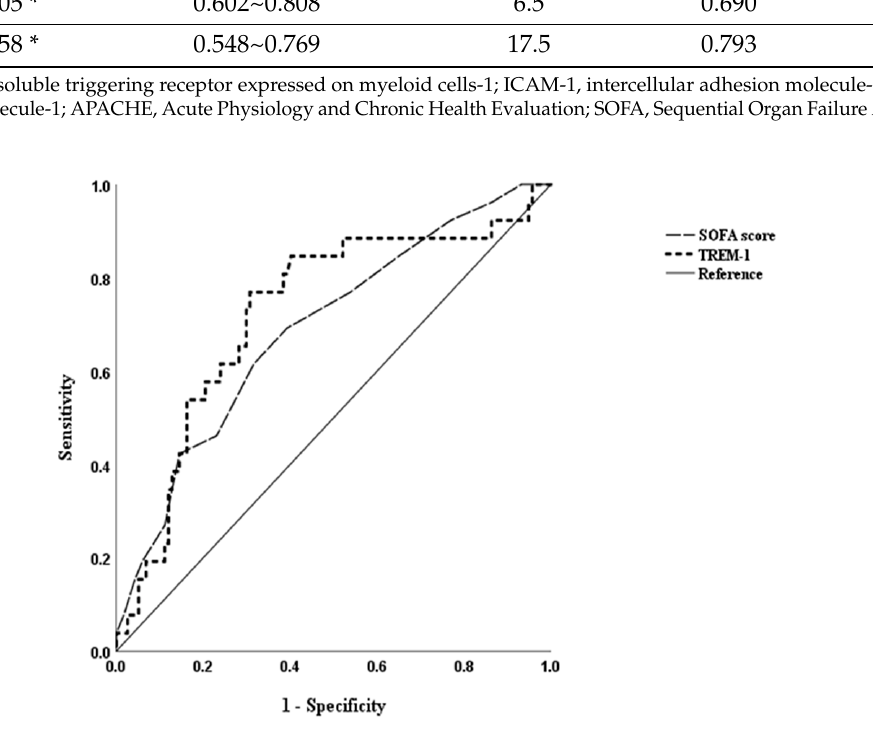
Figure 3. ROC curve of sTREM-1 in predicting sepsis related mortality.